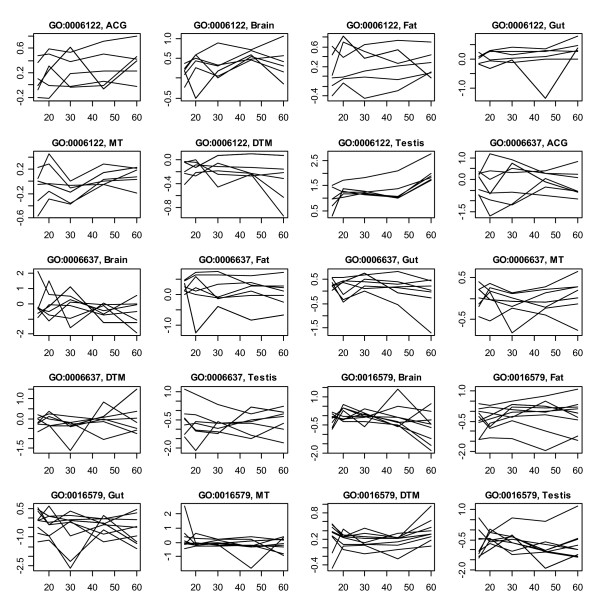
Tissue-specific transcriptional profiles of genes involved in 3 predictable GO biological processes. The plots were based on the averages of the duplicated measurements at each age points for the corresponding tissues. ACG, MT and DTM represent accessory gland, malpighian tubule, and dorsal thoracic muscle, respectively.